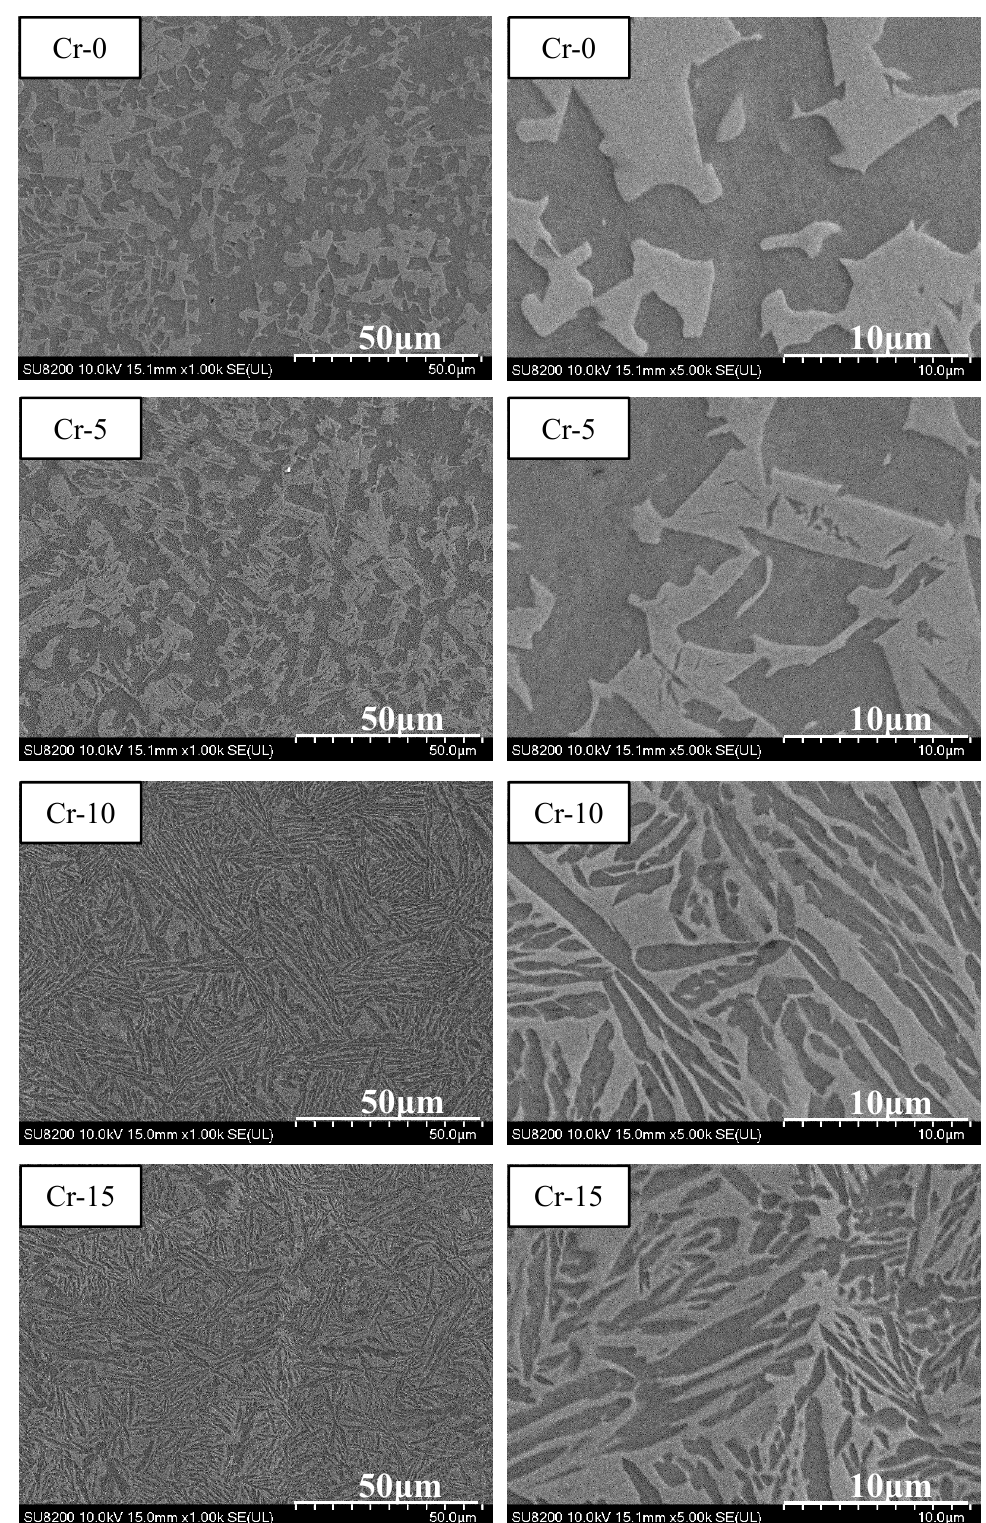
Figure 5. SEM images of the Al 50 (TiMnV) 50-x Cr x (x = 0, 5, 10, 15) alloys.